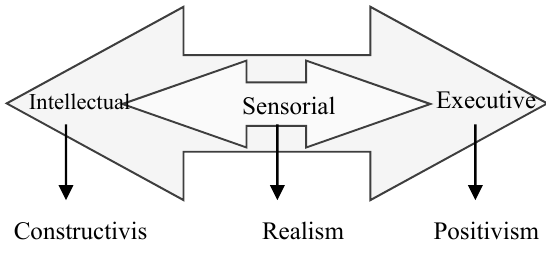
Figure 4. Kiwi and Kampenhood methodology [31].